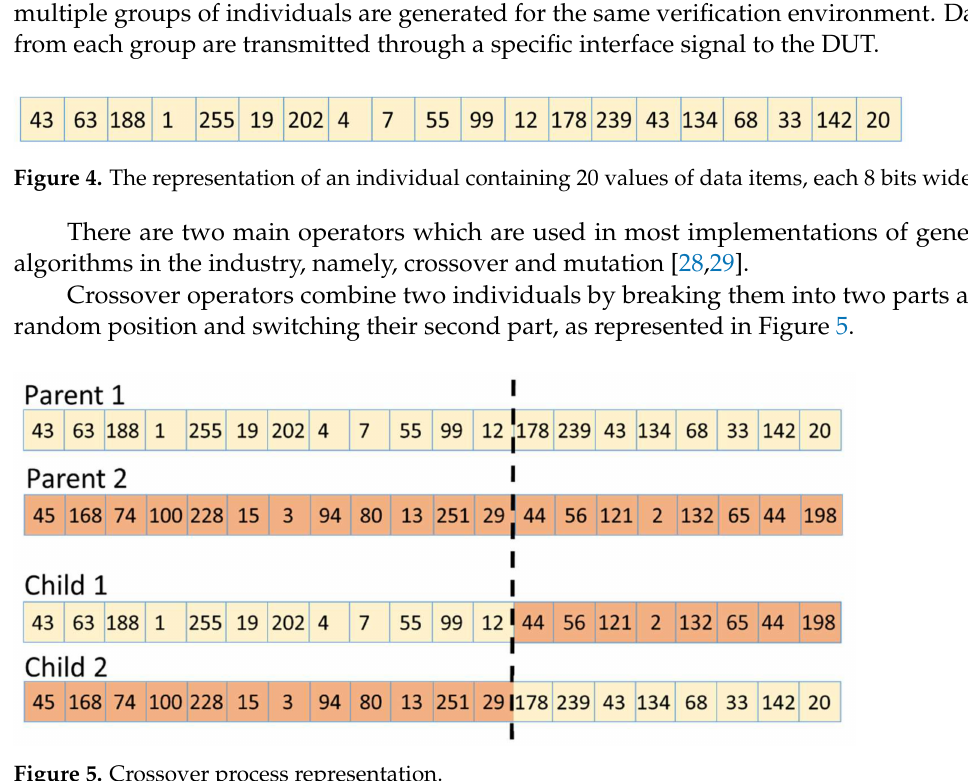
Figure 5. Crossover process